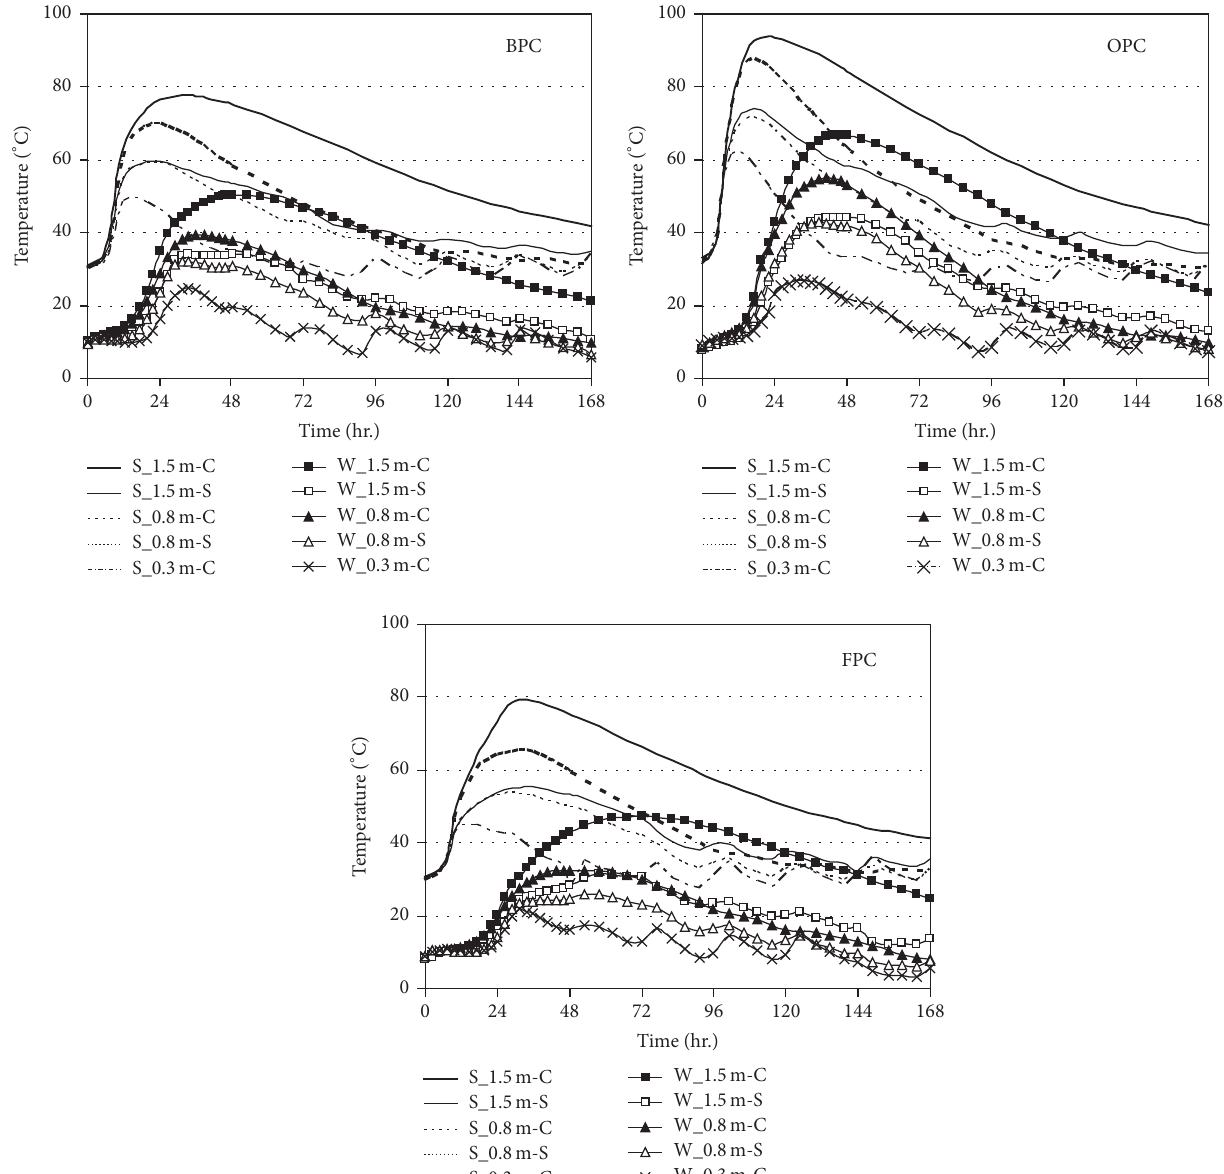
Figure 2: Temperature history in model walls. (S_1.5 m-C = S: summer, 1.5 m: size, C: center, W_1.5m-S = W: winter, 1.5: size, and S: surface).